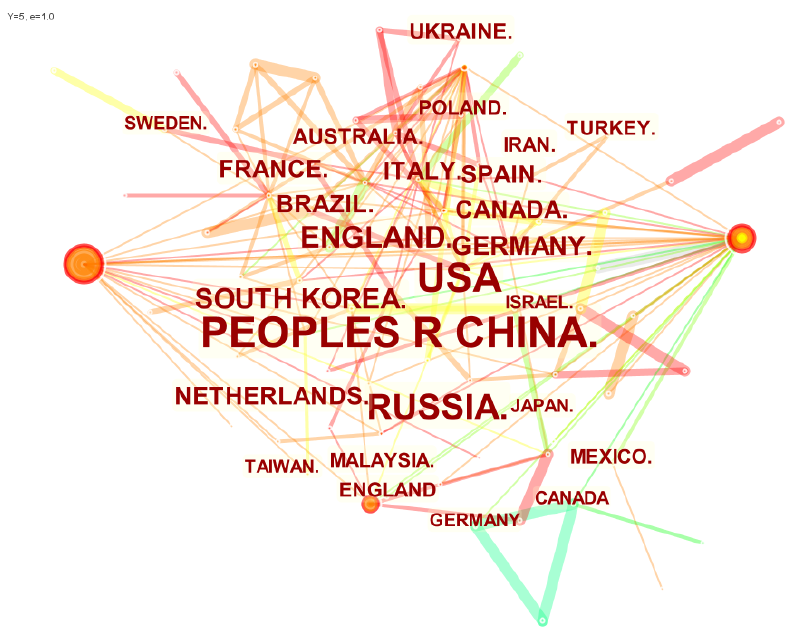
Figure 7. Co ‐ occurrence of country/region in FTZ contribution. (Note: Figure 7 is generated by the authors using CiteSpace, which is a free software that has been authorized for academic uses (see http://cluster.cis.drexel.edu/~cchen/citespace/, accessed on 21 April 2022)). From Figure 7, it is shown that mainland China and the US have a far bigger node size than other producers, where the count number is 200 for China and 153 for the US. As for the centrality represented by the thickness of the violet outer ring, the US is the first (0.4) and China and France are tied for second place (both 0.16). Table 2 summarizes the producers which were counted no fewer than 10 times. Table 2. FTZ’s count numbers of the country/region. Count Count Rank Centrality